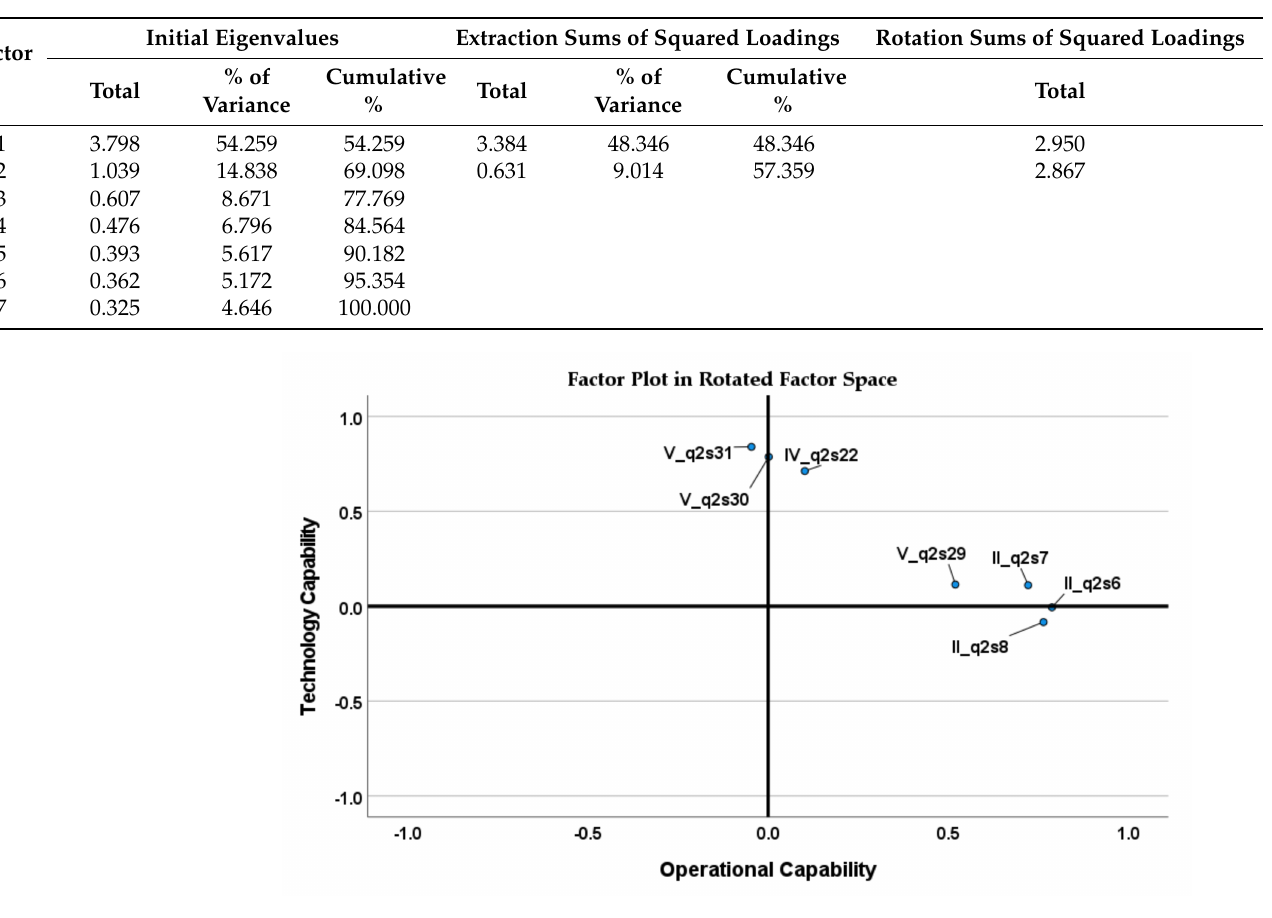
Figure 5. Factor plot in rotated factor space for variables IV_q2s22, V_q2s29, V_q2s30 V_q2s31, II_q2s6, II_q2s7, and II_q2s8.